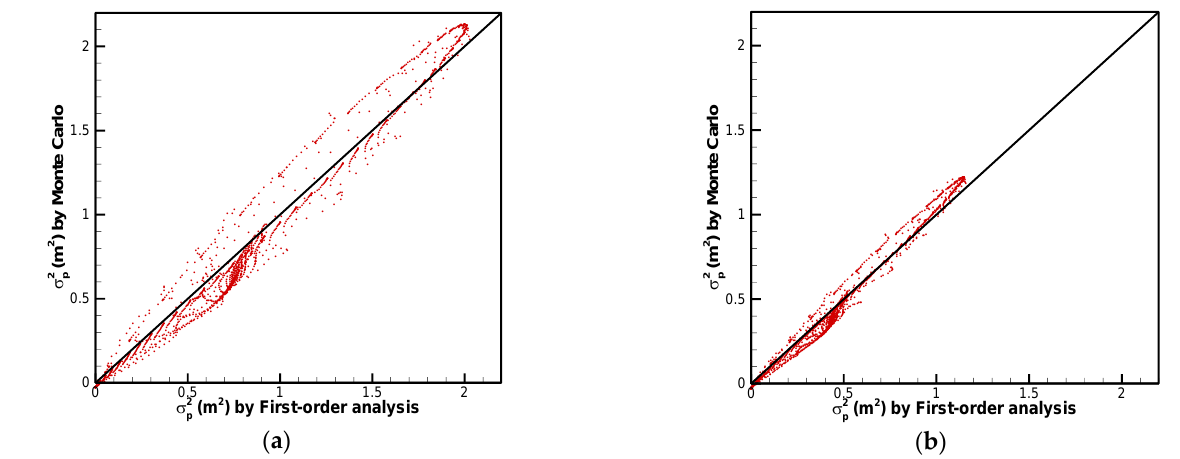
2 = 0.7 2 = 0.7 𝑠 = 0.7 𝑠 ln K s